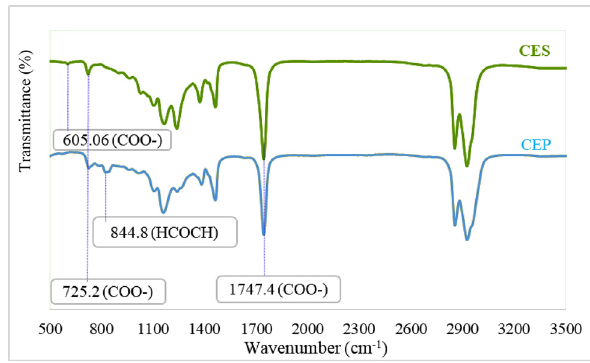
Figure 6: FT - IR spectra of CEP and CES product.